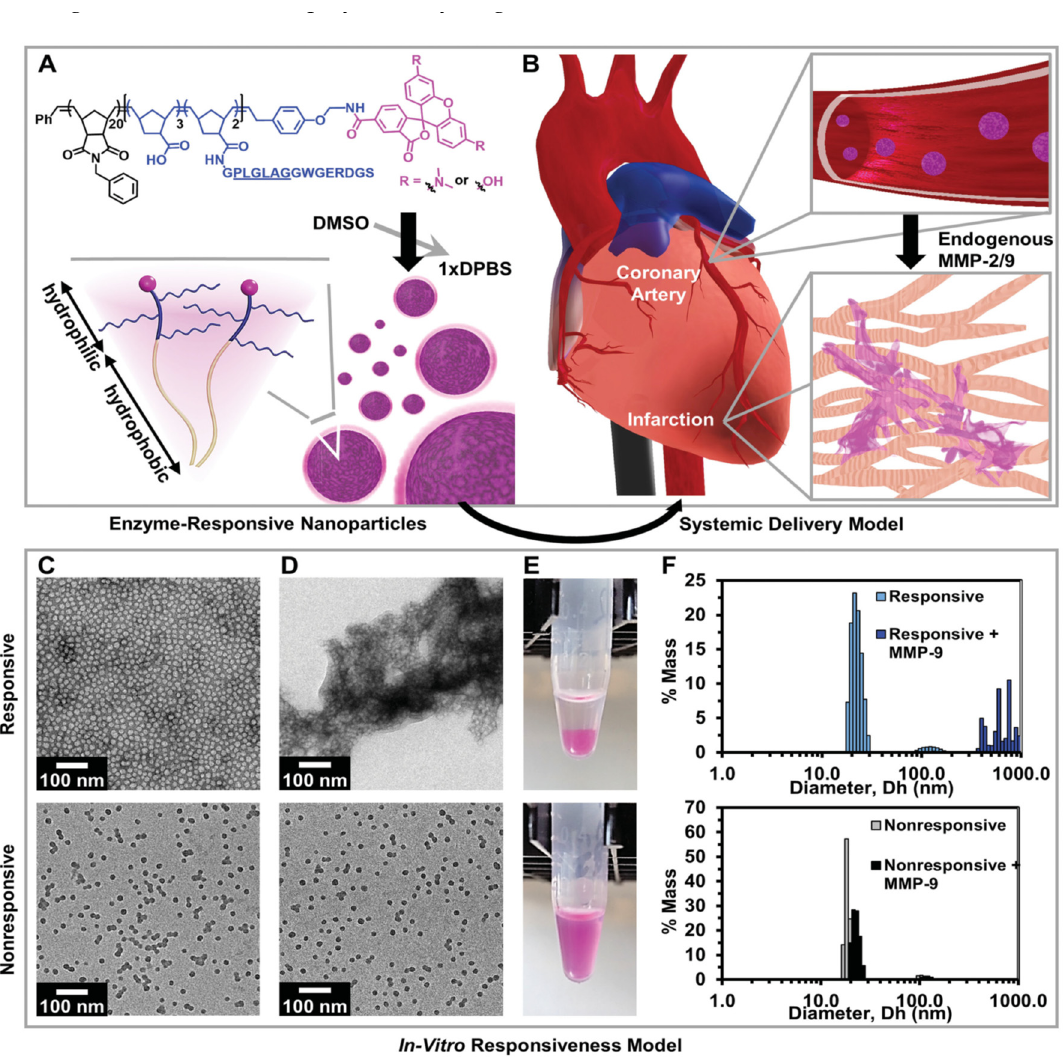
Figure 1. Responsive nanoparticles target, accumulate, and are retained within an acute MI due to enzyme-induced aggregation. ( A ) Diagram of a dye-labeled brush peptide–polymer amphiphile (PPA) containing an MMP-2 and MMP-9 specific recognition sequence, shown underlined. PPAs self-assemble into nanoparticles through hydrophobic–hydrophilic interactions when dialyzed into aqueous buffer. ( B ) Schematic of nanoparticles freely circulating in the bloodstream (not to scale) upon systemic delivery. Nanoparticles enter the infarct tissue through the leaky acute MI vasculature, and up-regulated MMPs within the infarct induce the formation of an aggregate-like scaffold. ( C ) In vitro, responsive (top) and non-responsive (bottom) nanoparticles are monodisperse micelles with diameters of 15–20 nm, and ( D ) upon activation, only responsive nanoparticles form an aggregate-like sca ff old. ( E ) Corresponding images of nanoparticle solutions following activation. ( F ) Dynamic light scattering of nanoparticles before and after MMP activation. Reproduced with permission from [48], Wiley-VCH,